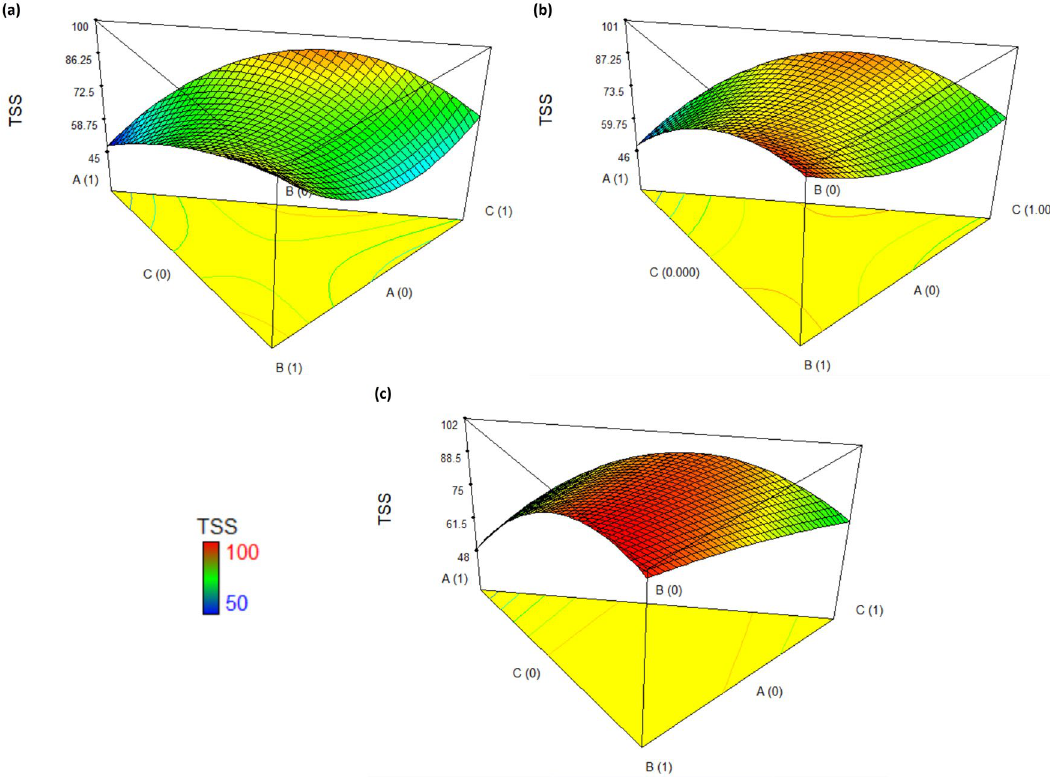
Figure 4. 3D response surface plots for the TSS removal in ceramic industry wastewater using coagulant doses: ( a ) low-200 mg/L, ( b ) medium-500 mg/L, and ( c ) high-800 mg/L.